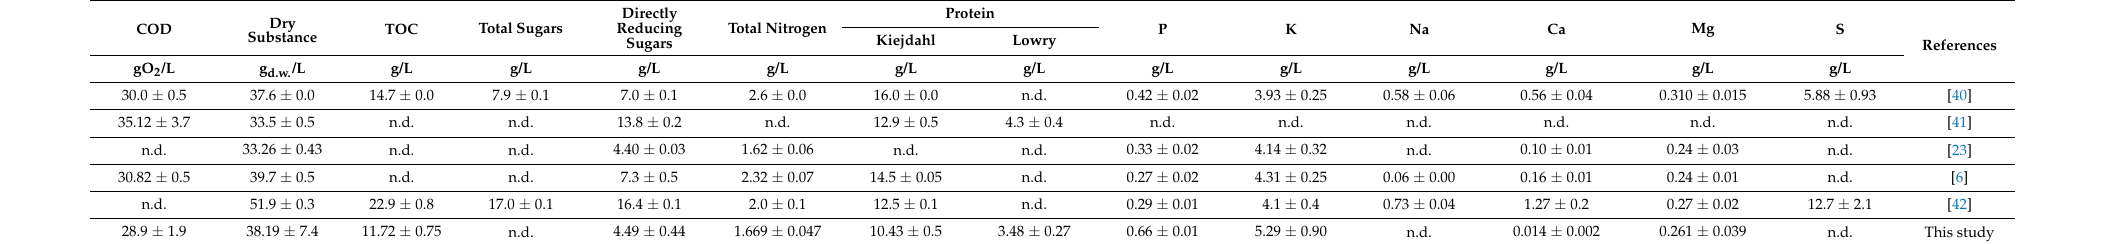
Table 1. Characteristics of deproteinized potato wastewater (DPW) used in this study (las vers) and its comparison to